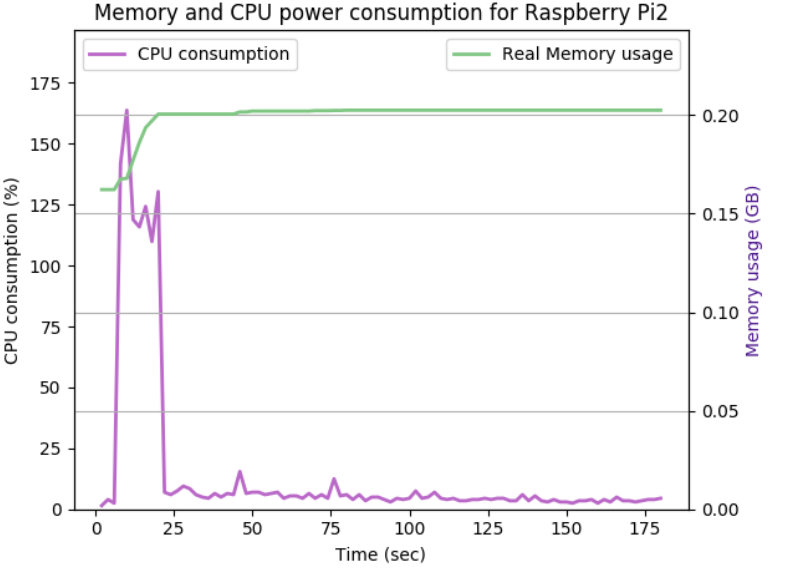
Figure 13. The CPU and memory utilization of the Raspberry Pi device using TLS_DHE_RSA_WITH_AES_128_GCM_SHA256, keysize =